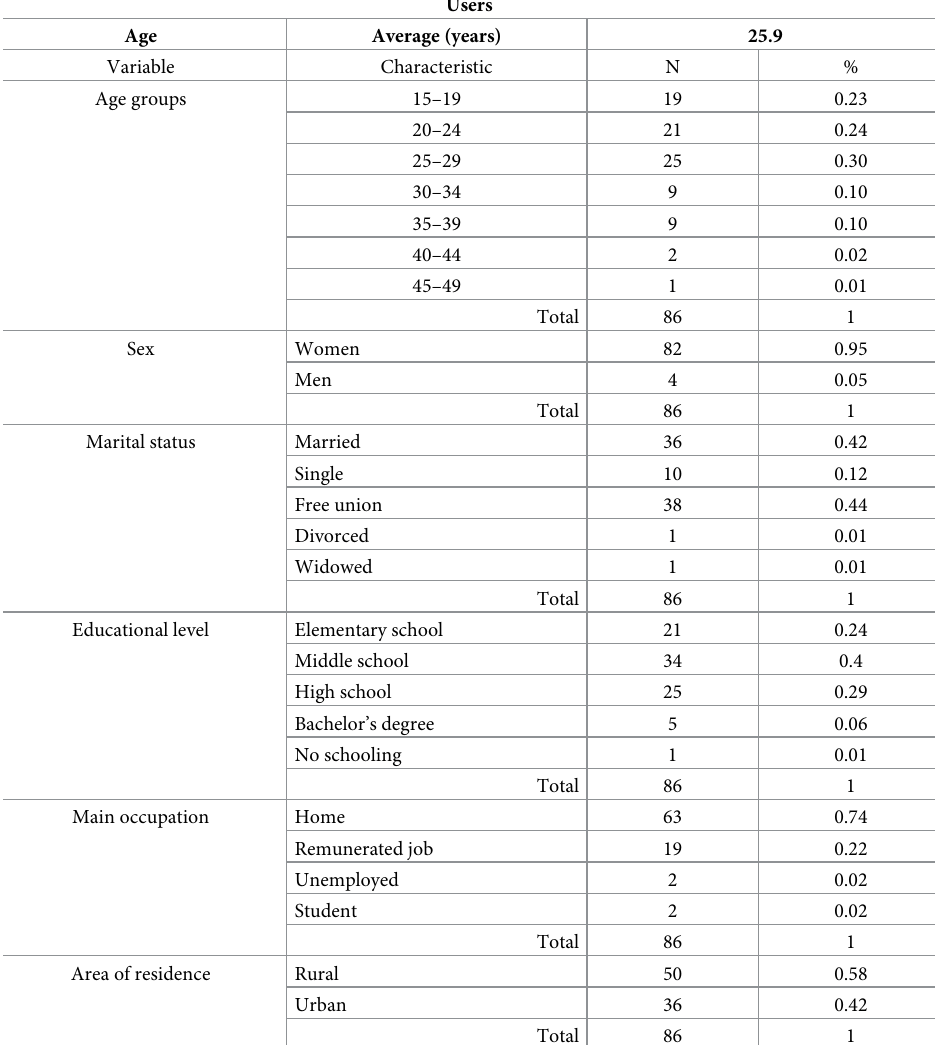
Table 1. Characteristics of the population